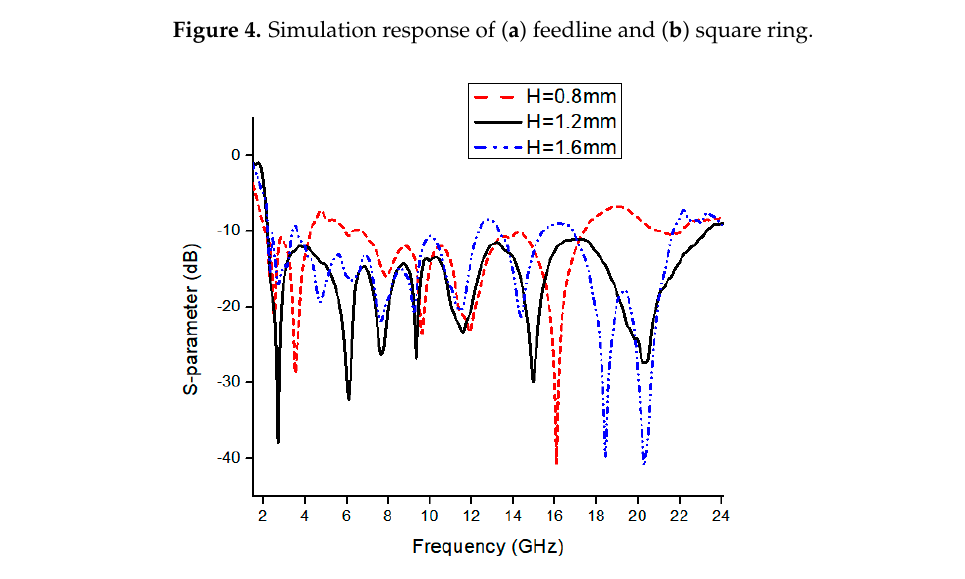
Figure 5. Simulation response of substrate height.